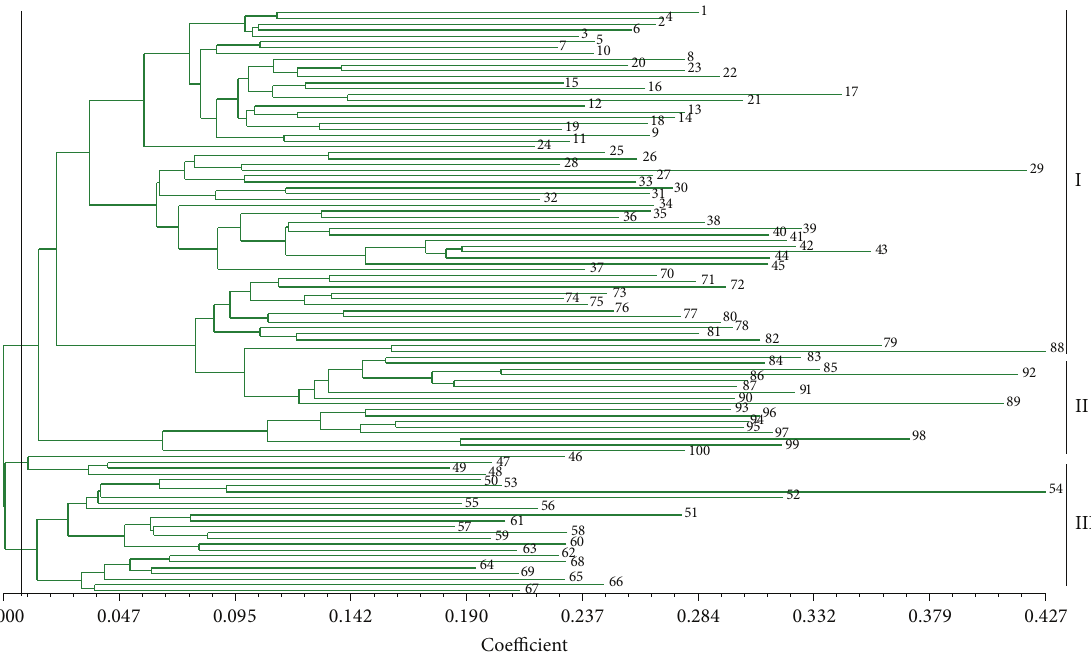
Figure 6: Dendrogram of the 100 S. scitamineum isolates (numbers 1–100) generated by UPGMA based on the combined ISSR + SP-SRAP data set.